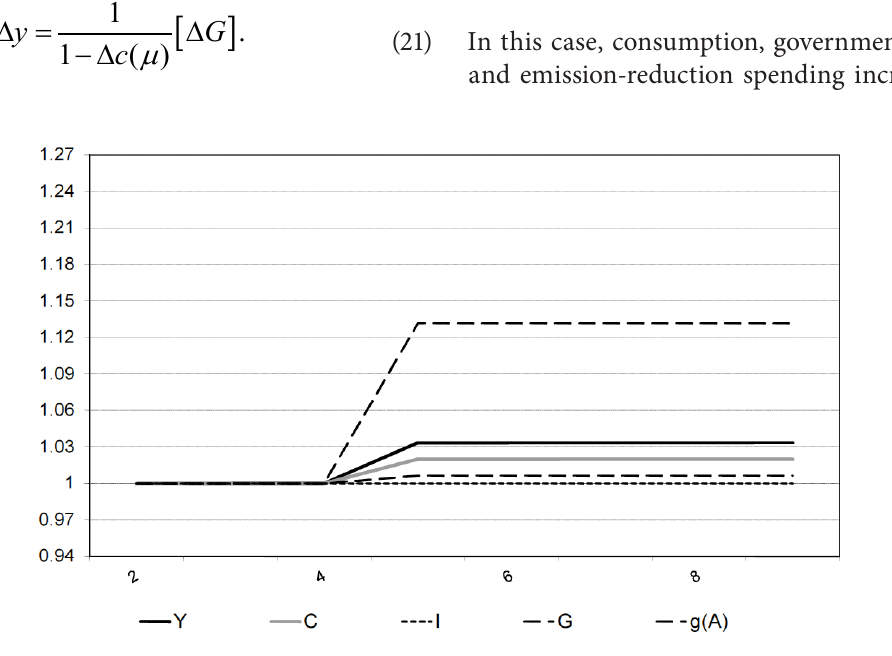
Figure 4. Increased public spending (with the budget deficit) while maintaining the carbon tax (Case